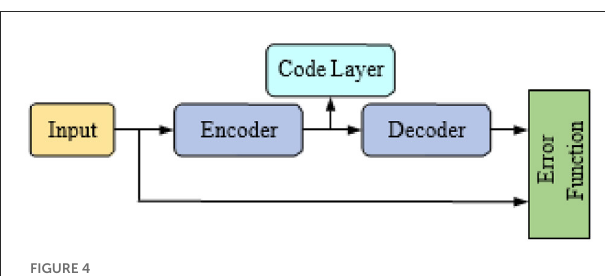
FIGURE4 Representation of an autoencoder (Yan and Han, 2018).